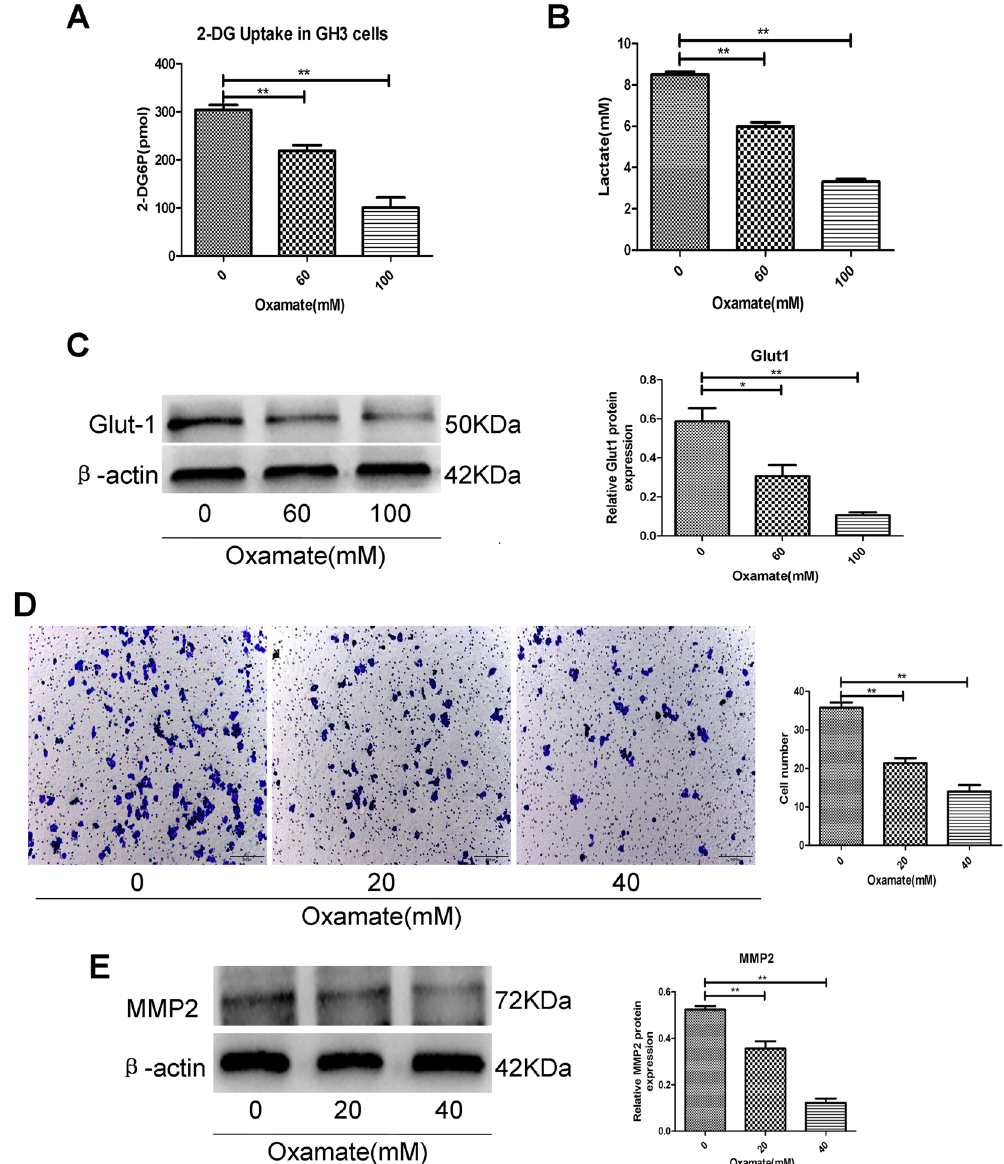
Figure 4. Inhibiting LDHA by oxamate decreased cell glucose uptake, lactate secretion and invasion. ( A ) The histogram represents glucose uptake of GH3 cells were exposed to 0, 60, and 100 mM oxamate for 48 h (n = 3, ± SEM). ( B ) The histogram represents lactate proudction of GH3 cells in aboved groups (n = 3, ± SEM). ( C ) Protein expression level of Glut-1 was examined by Western blot in aboved groups (n = 3, ± SEM). ( D ) GH3 cells were exposed to 0, 20, and 40 mM oxamate for 48 h, and then cell invasion were evaluated by transwell assay, Original magnification, × 100 (n = 5, ± SEM). ( E ) GH3 cells were exposed to 0, 20, and 40 mM oxamate for 48 h and then protein expression levels of MMP-2 were examined by Western blot (n = 3, ± SEM). * P < 0.05; ** P <